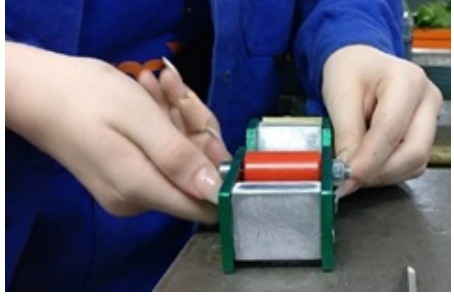
Fig. 4. Production process videos